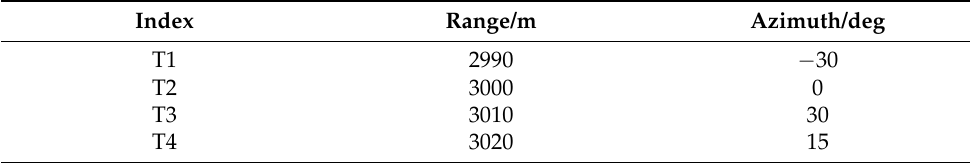
Table 2. Prominent target positions in simulation.